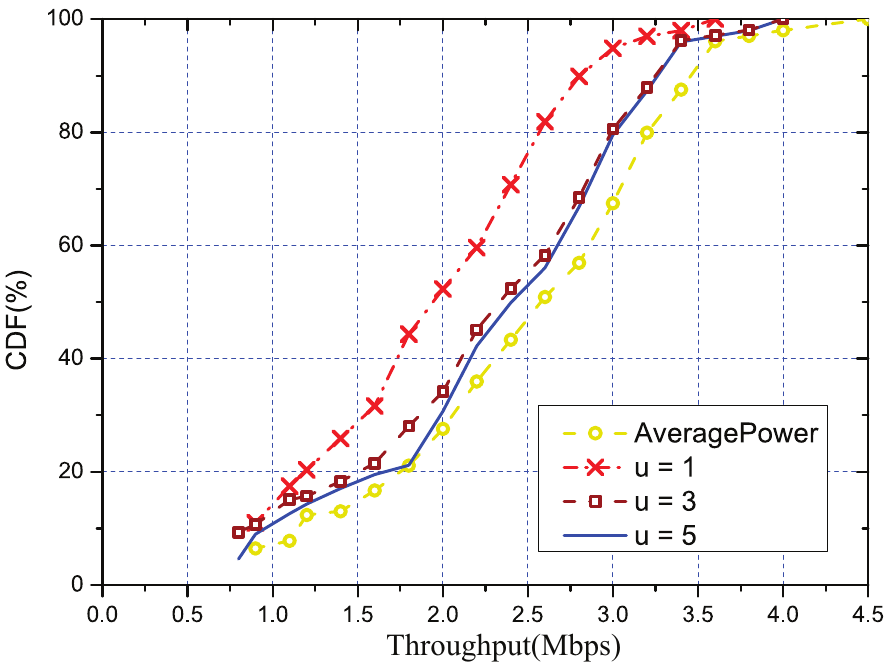
Figure 6. The CDF of throughput under different u , where u denotes the number of channels selected to perform the measurement in every representative